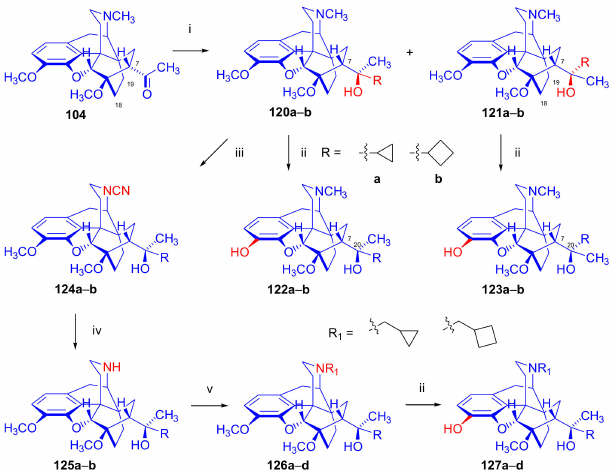
Figure 37. Synthesis of 20-cyclopropyl- and 20-cyclobutyl-substituted buprenorphine analogues. Reagents and conditions : (i): RMgBr, THF, reflux, 1.5 h; (ii): KOH, diethyleneglycol, 220 ◦ C, 2 h; (iii): BrCN, CH 2 Cl 2 , reflux, 4 h; and (iv): KOH, diethylene glycol, 175 ◦ C, 1.5 h; R 1 CH 2 Br, Mg(OAc) 2 , DMF, 100 ◦ C, 2